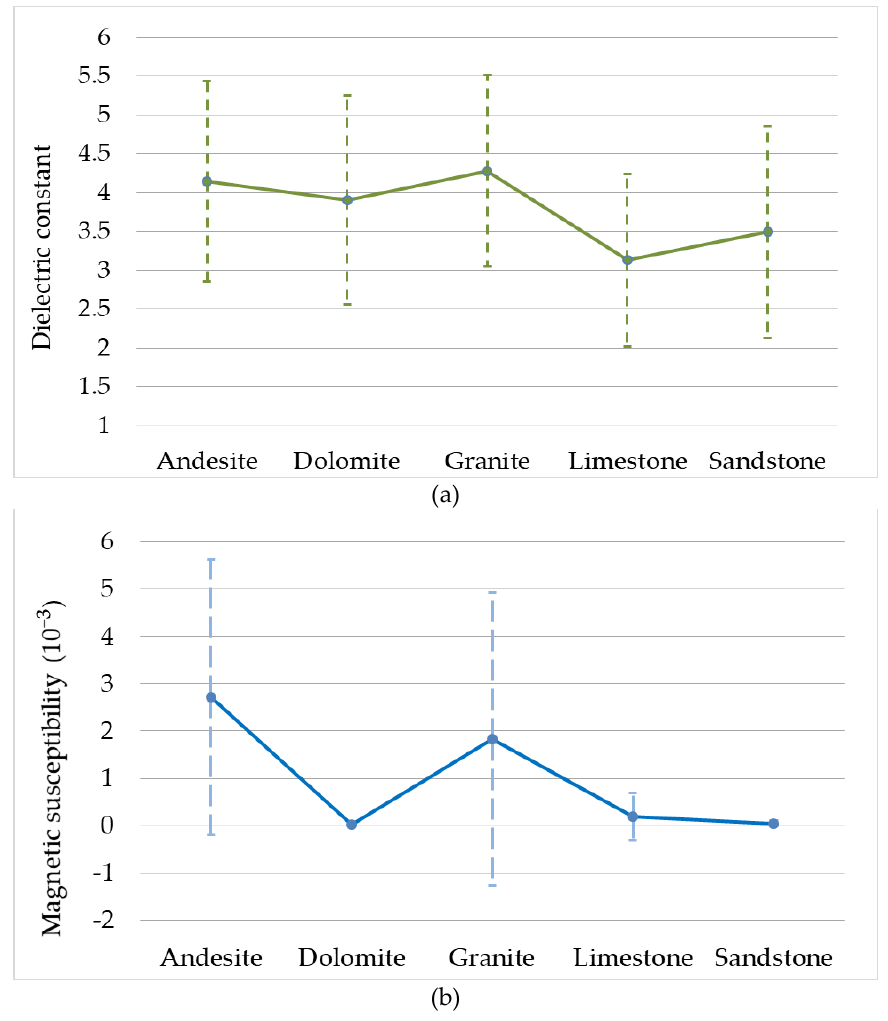
Figure 7. The ( a ) averaged dielectric constant and ( b ) averaged magnetic susceptibility. The lines are the mean values and the vertical dash lines are the standard deviations.